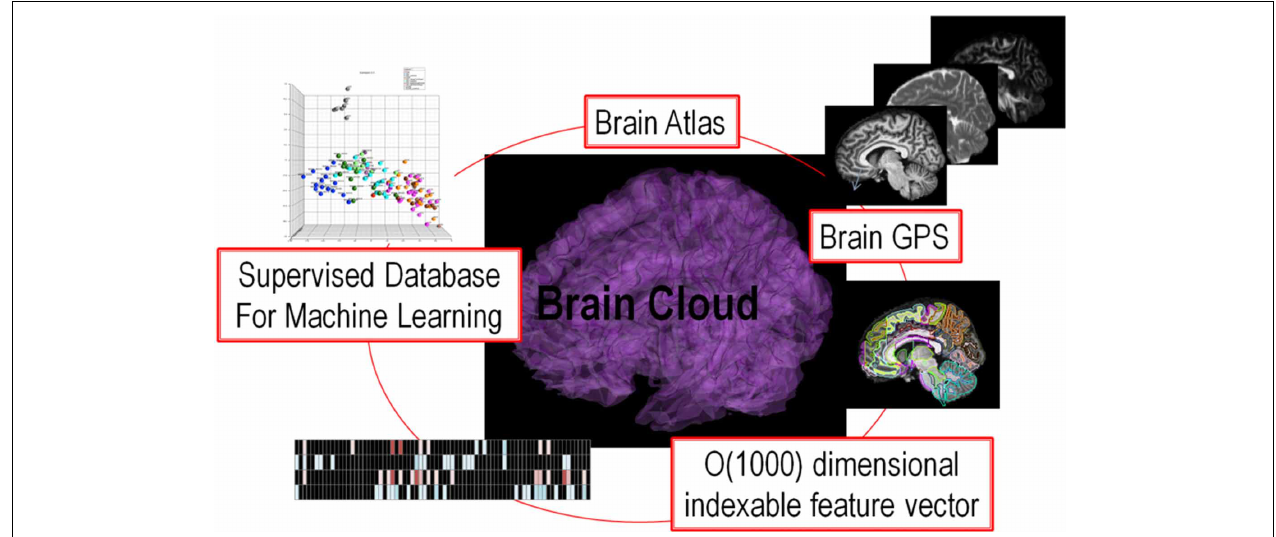
FIGURE 1 | Showing the core components of the high-throughput neuroinformatics pipeline including content (the atlas family), the personalization technology (GPS DiffeoMapping), and machine learning on the index or high-dimensional feature